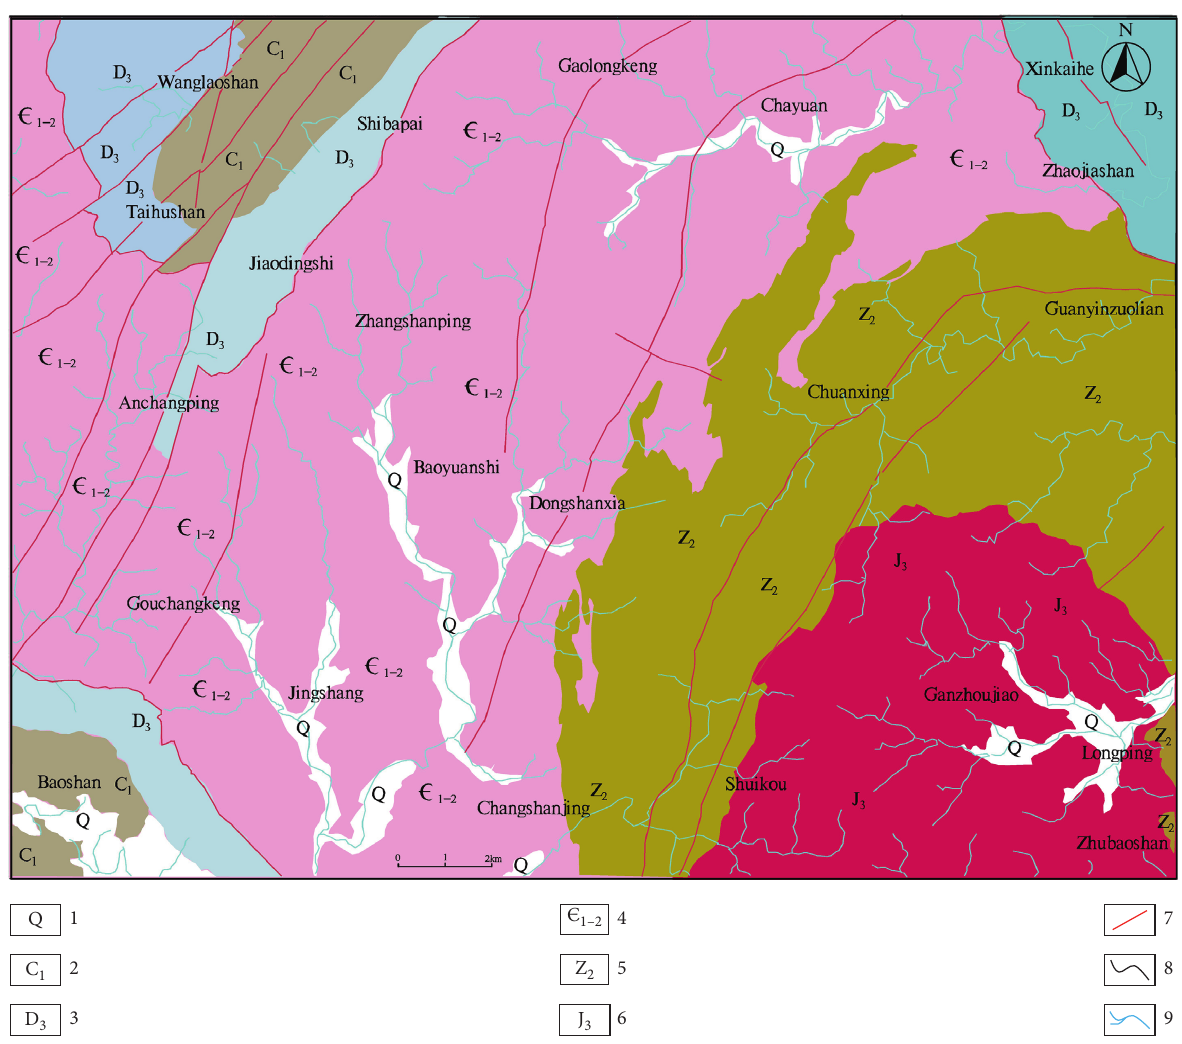
Figure 1: Geological map of Northwest Xingguo County. 1: quaternary; 2: early carboniferous; 3: late Devonian; 4: early and middle-late Cambrian; 5: middle Sinian; 6: granite in late Jurassic; 7: fault; 8: stratigraphic boundary; 9: river. Table 1: Groundwater system division in Northwest Xingguo